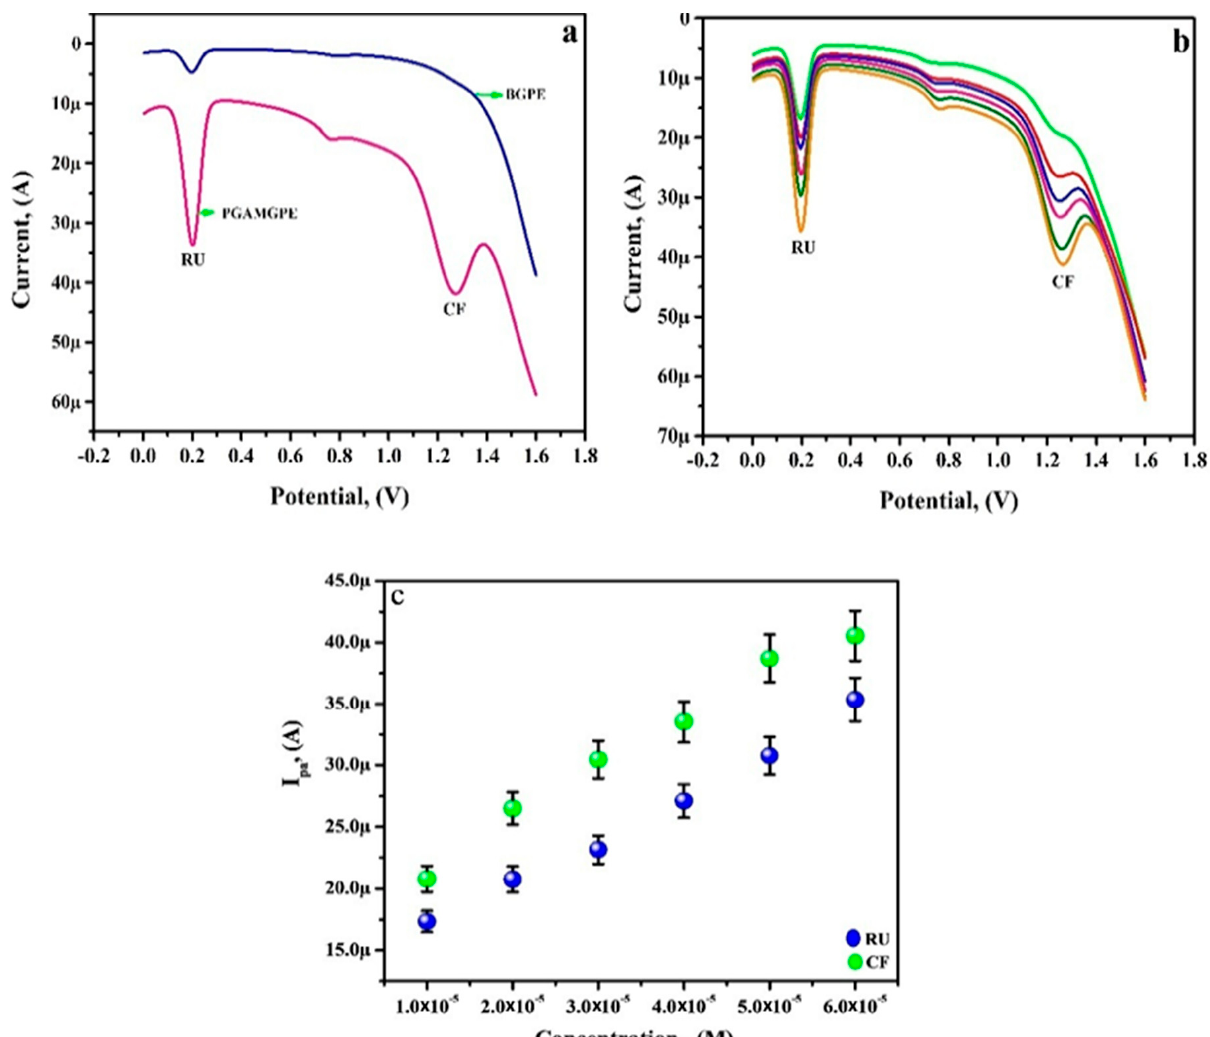
Figure 10. ( a ) DPVs for simultaneous analysis of RU, CF (0.1 mM) at PGAMGPE and BGPE in PB. ( b ) DPVs for simultaneous investigation with variable concentrations (10.0 to 60.0 µM) of RU and CF. ( c ) Plot of I pa versus [RU] and [CF] under optimum condition.